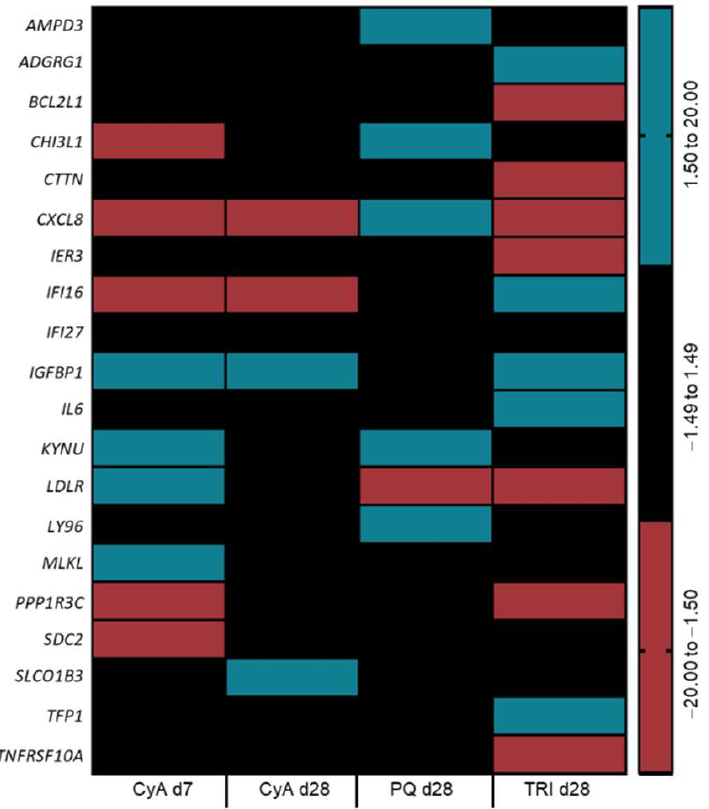
Figure 5. Identification of biomarkers of drug-induced cholestasis according to [20], per condition. All the gene names are listed in Table S2 in the supplementary materials. Averaged results from spheroids from three PHH donors. CyA—cyclosporine-A; d—day; PHH—primary human hepatocytes; PQ—paraquat; TRI—triclosan.